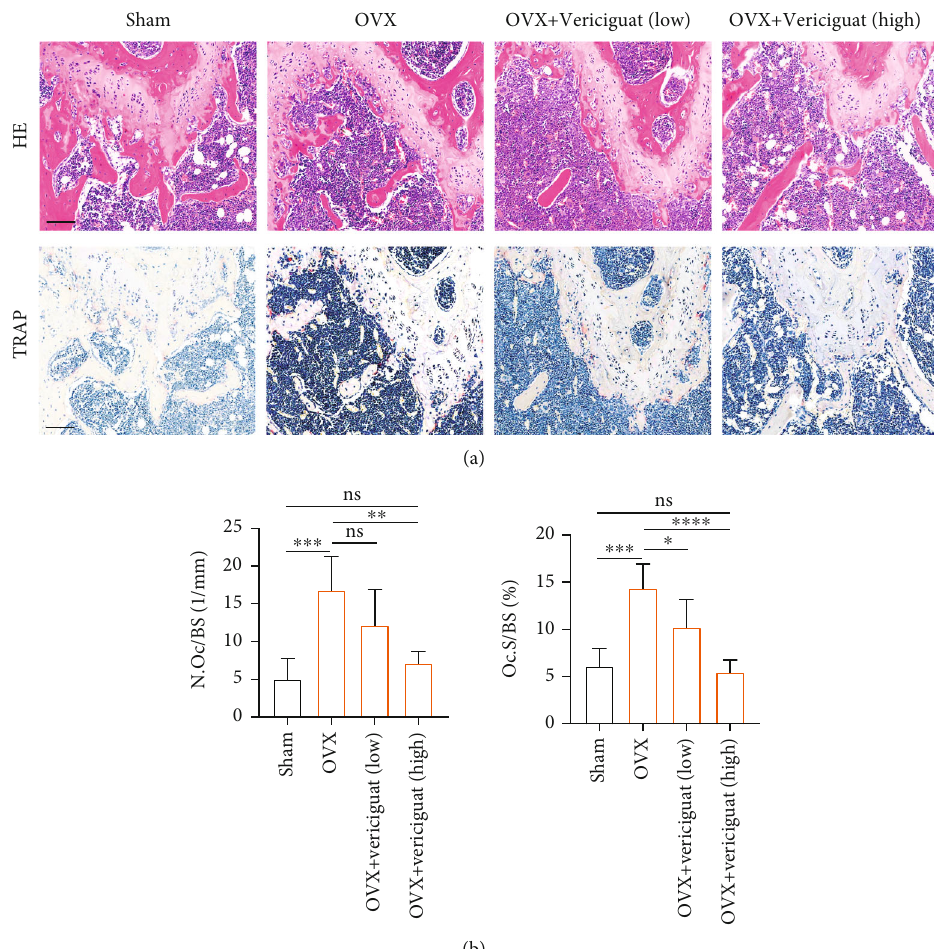
Figure 10: Validation of the e ff ects of Vericiguat on OVX-induced bone loss in vivo indicated by histological analysis. (a) Representative images of H&E staining and TRAP staining within the selected metaphyseal region from the sham group, OVX group, low-dose group, and high-dose group ( n = 5 ). (b) The number and area of TRAP + cells per bone surface were quanti fi ed. ∗ p < 0 : 05 , ∗∗ p < 0 : 01 , ∗∗∗ p < 0 : 001 , and ∗∗∗∗ p < 0 : 0001 . Scale bar = 100 μ m